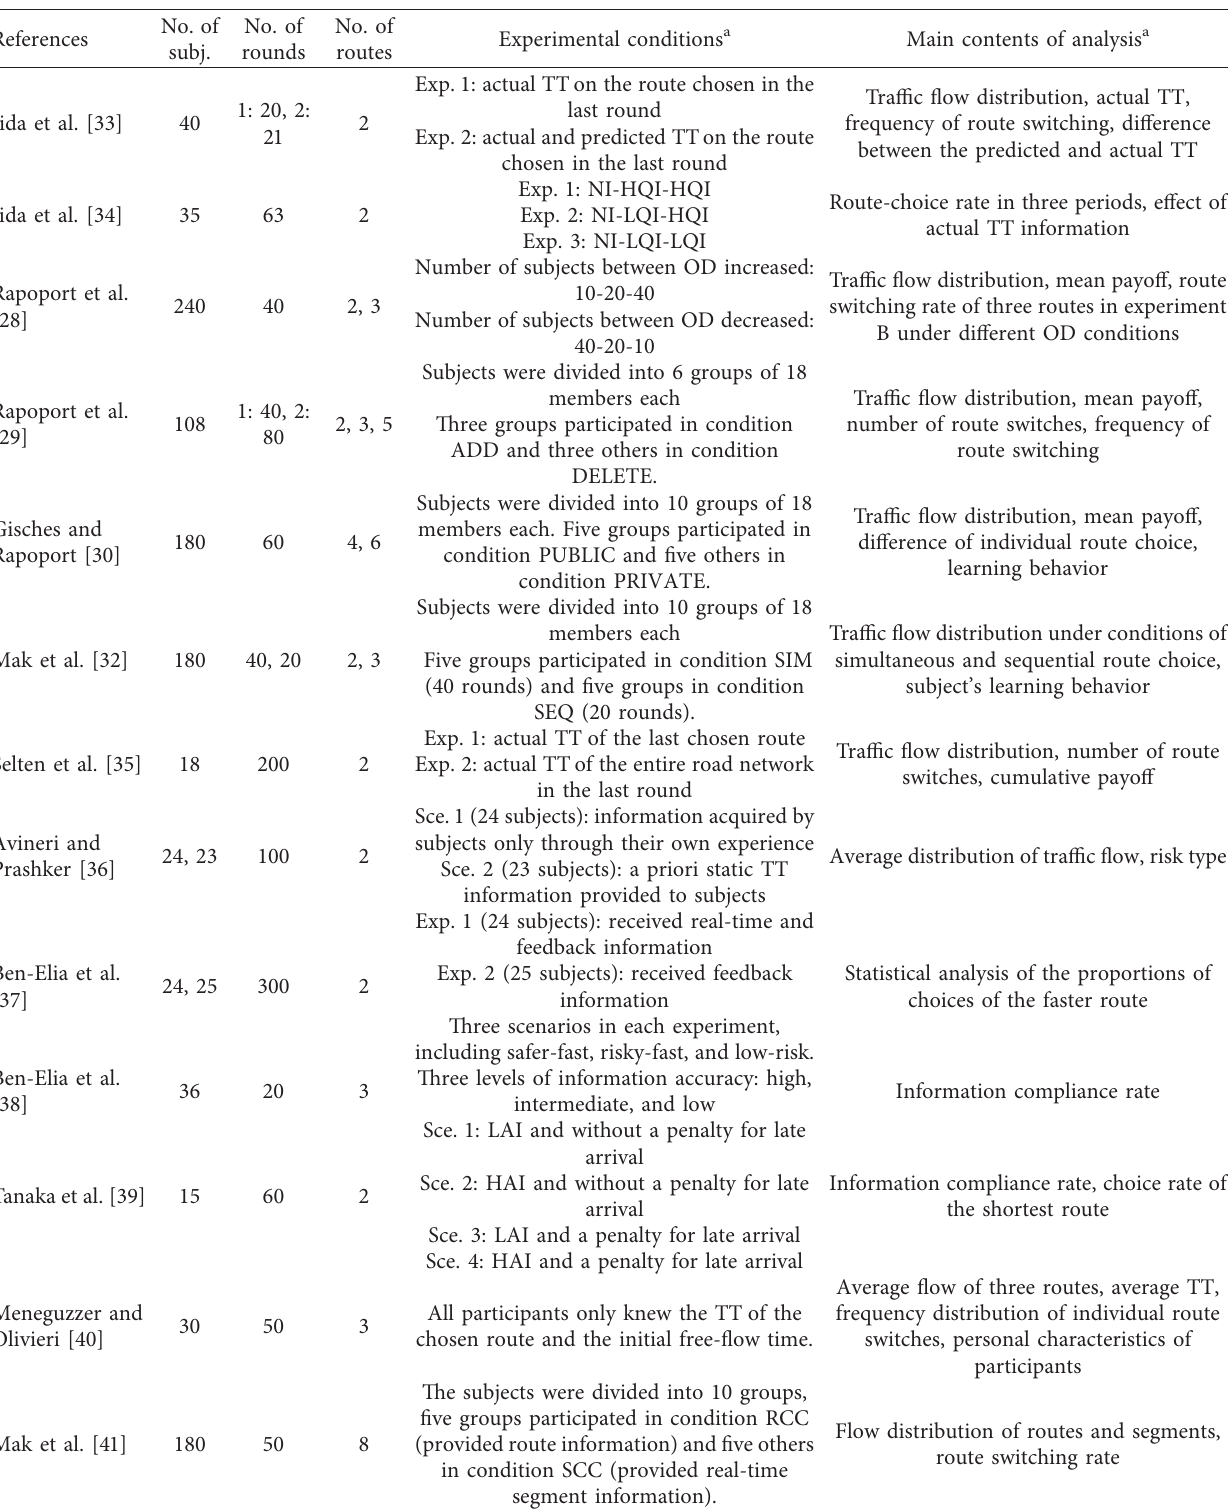
Table 1: Summary of relevant literature on experimental studies of travelers’ day-to-day route-choice